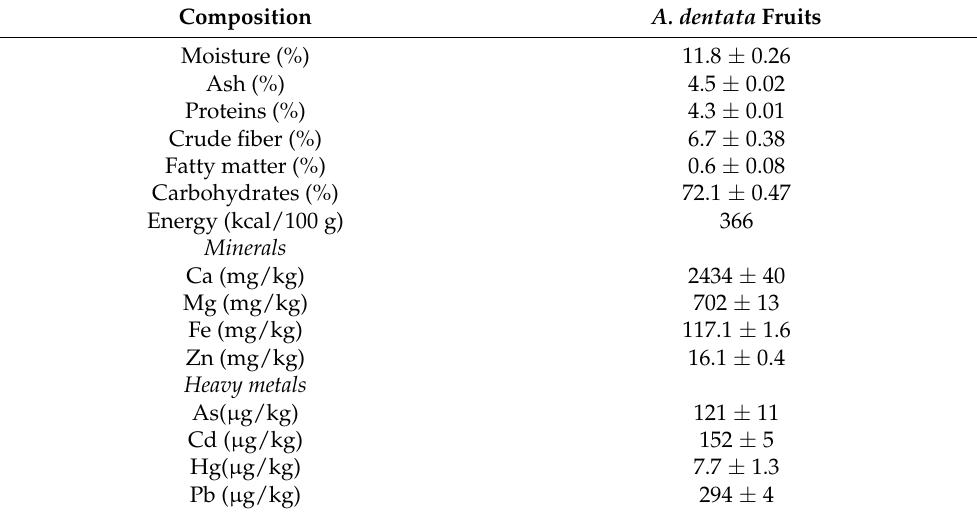
Table 1. Proximal composition and mineral and heavy metal contents of A. dentata